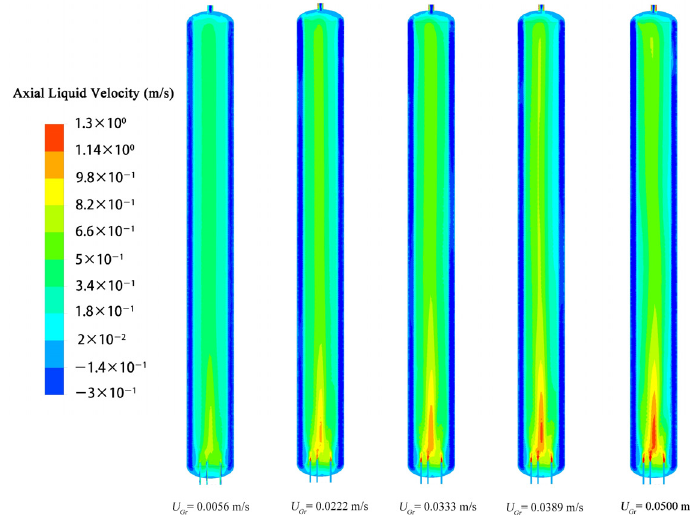
Figure 10. Axial liquid velocity distribution with U Gr at a total column height of 15 m.